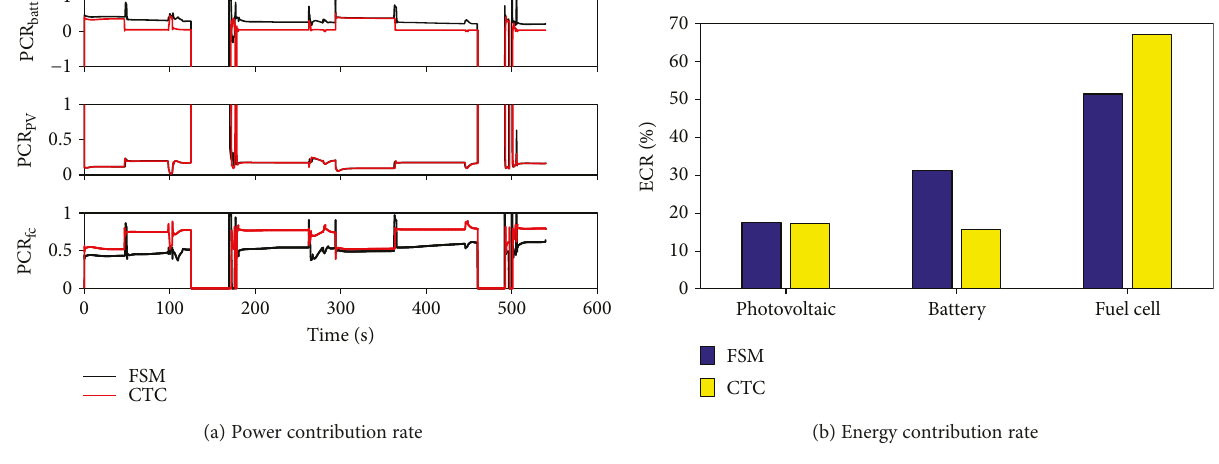
Figure 14: Power and energy contribution rates of each power source. Table 5: Comparison of the state of the battery and fuel cell between FSM and